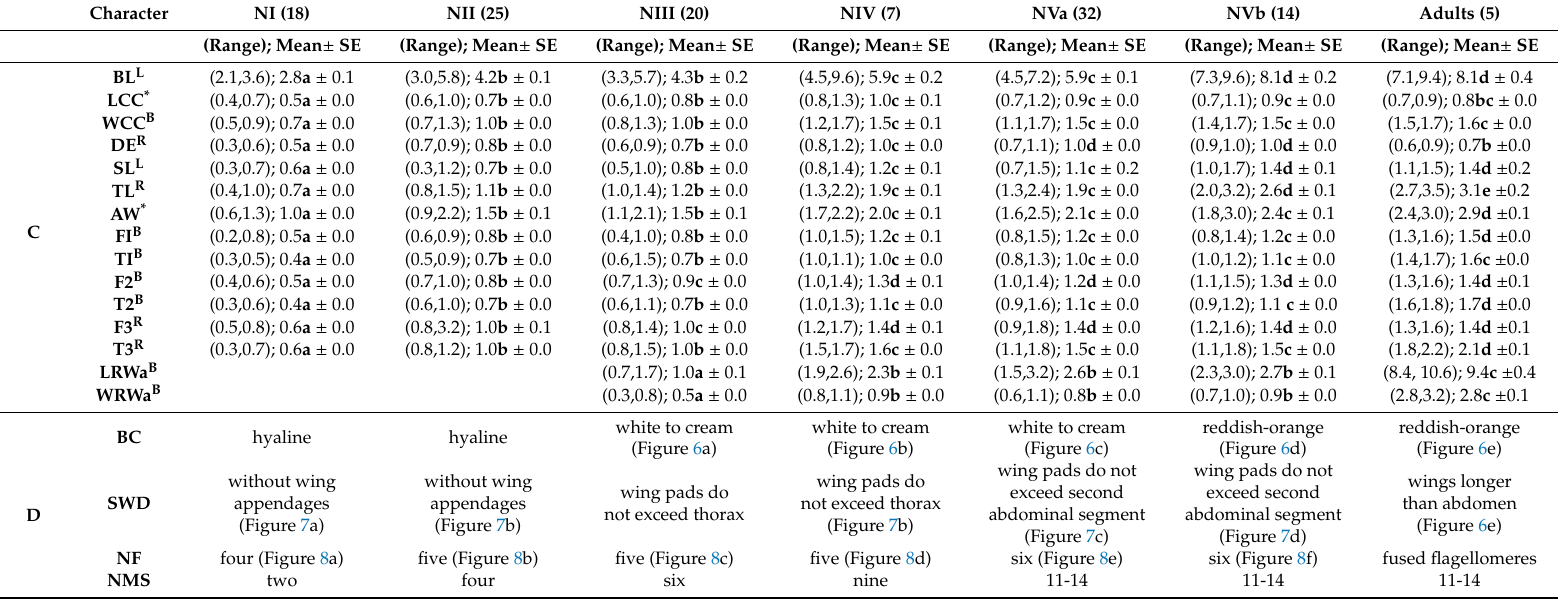
Table 1. Morphological characteristics analyzed from both nymphs (NI-NVb) and adults of Ocoaxo assimilis ; basic statistics and results of the Kruskal Wallis test are displayed for 15 continuos